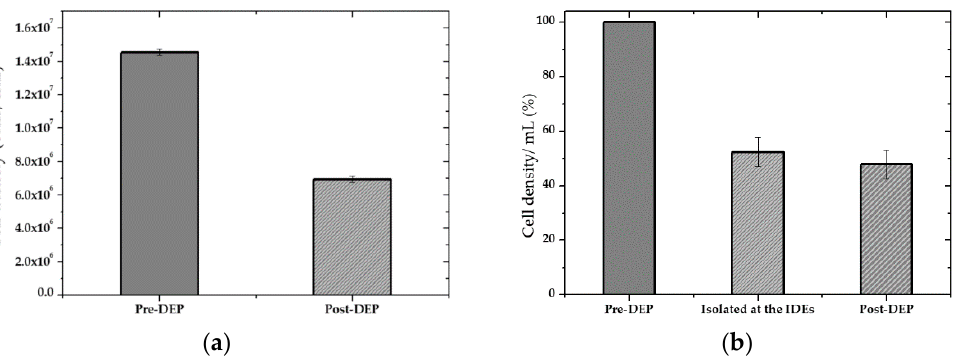
Figure 13. Cell density assay before and after DEP. The cells were immobilized using pDEP at 1 MHz, 20 V (cid:2926)(cid:2926) : ( a ) Approximate cell density before (Pre-DEP) and after measurement (Post-DEP); ( b ) Percentage of trapped and released cell density after DEP.